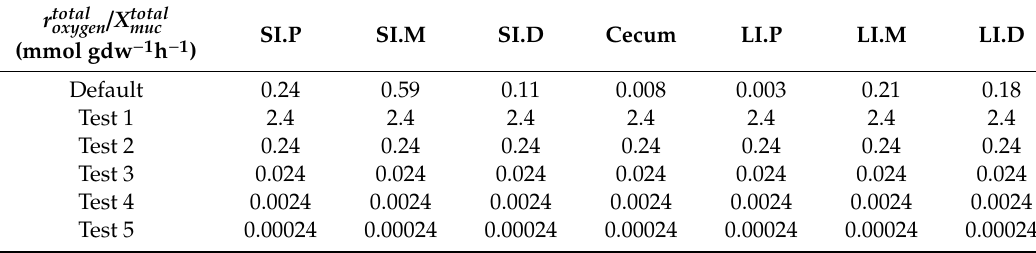
Table 5. Sets of values tested for the oxygen-per-mucosal-biomass availability r total oxygen / X total muc . r total oxygen / X total